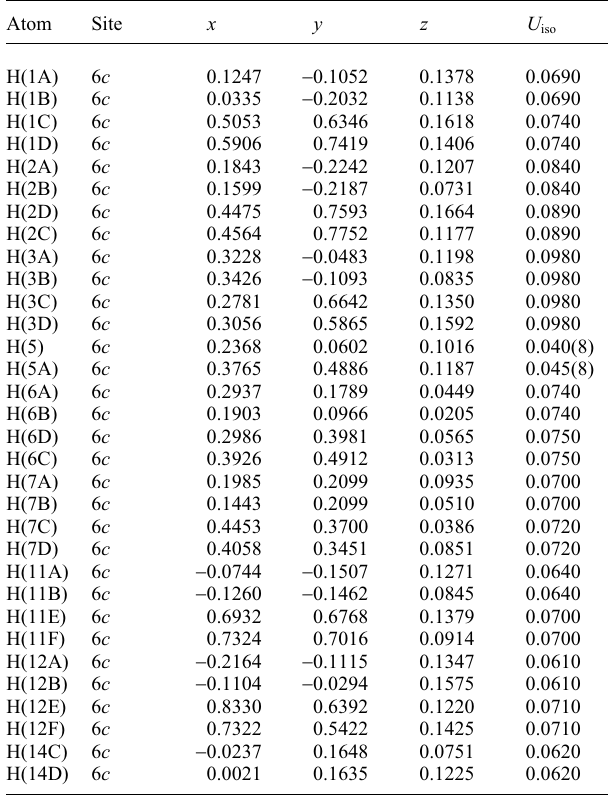
Table 2. Atomic coordinates and displacement parameters (in Å 2 )